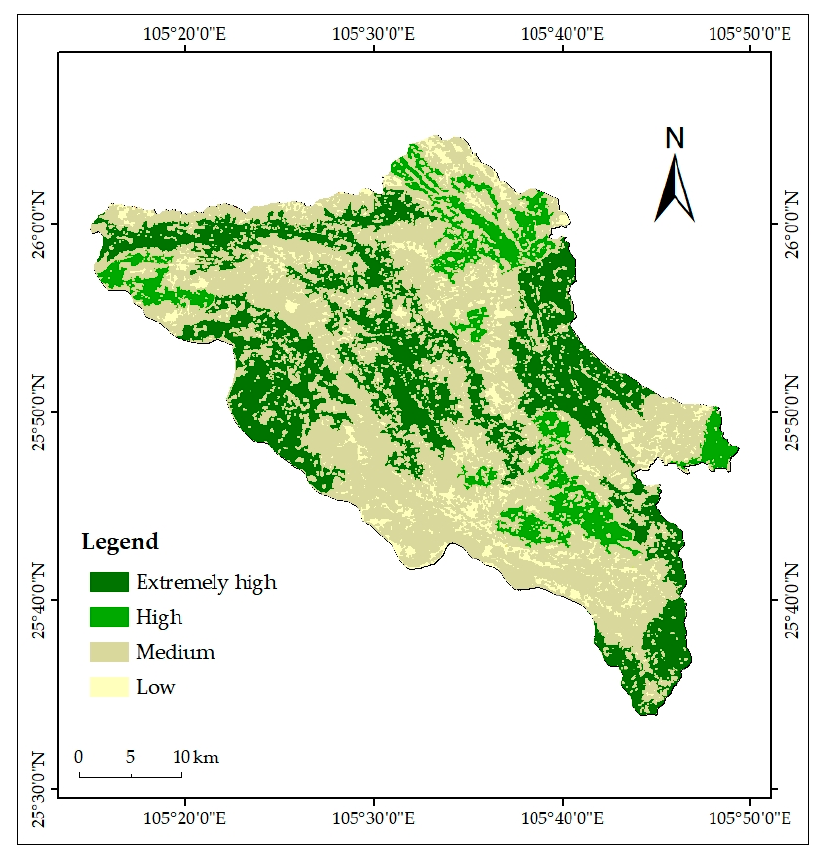
Figure 6. Guanling County landscape connectivity distribution map.